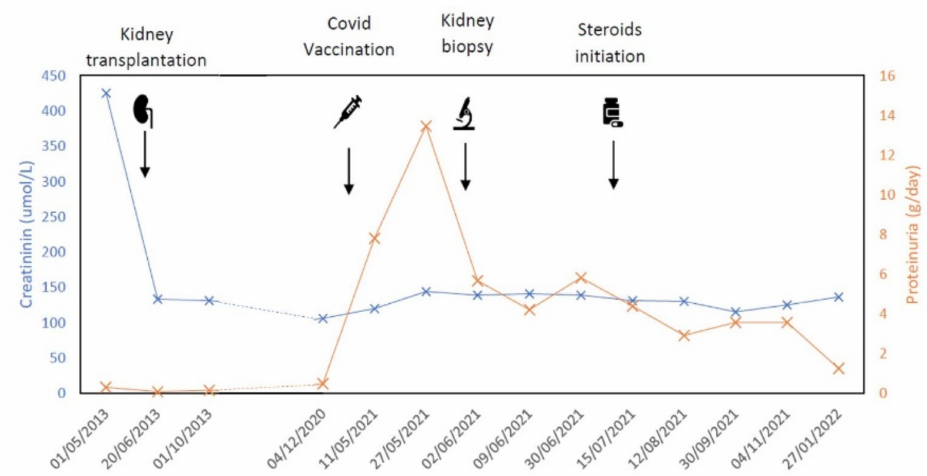
Figure 2. Creatinine and proteinuria evolution through time and defining events. The X axis shows the dates of analysis. The Y axis (left) shows creatinine, and the Y axis (right) shows proteinuria. The patient was receiving 4 mg of tacrolimus and had stable levels ranging from